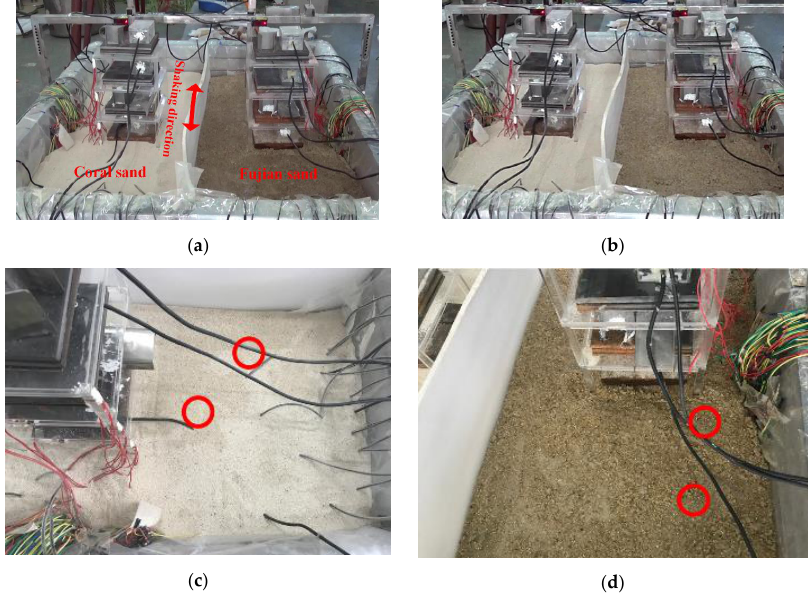
Figure 6. Macroscopic phenomena of the model soil and structure: ( a ) Before test; ( b ) After 0.1 g shaking excitation; ( c ) Coral sand site after 0.2 g shaking excitation; and, ( d ) Fujian sand site after 0.2 g shaking excitation.